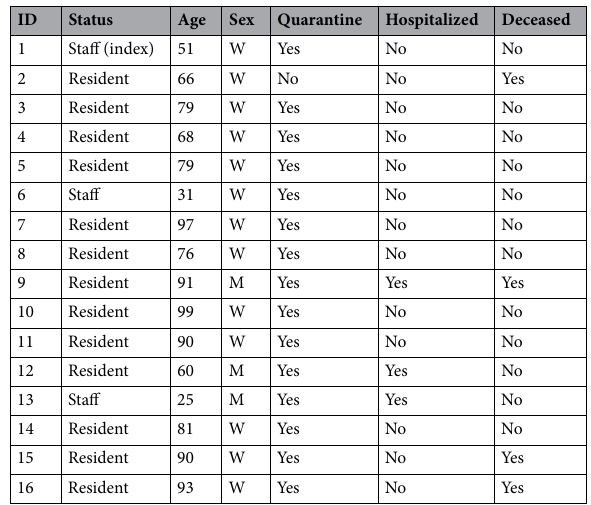
Table 3. Overview of confirmed COVID-19 cases in nursing home NH03. Order by the onset of symptoms.